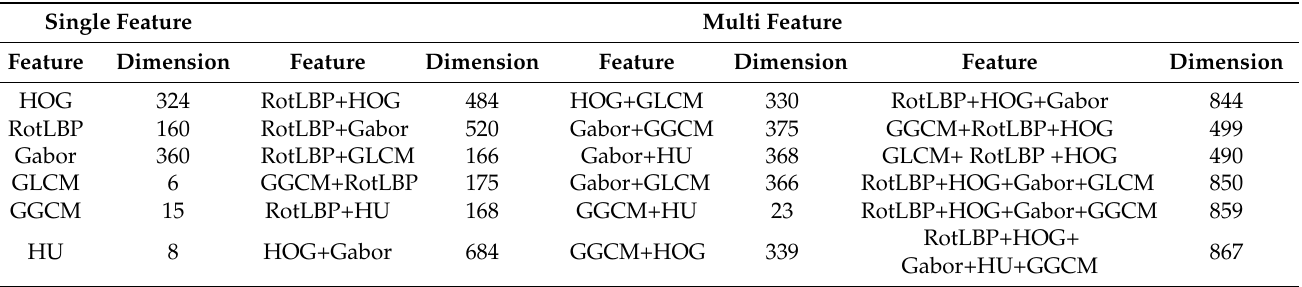
Table 4. Multi-feature fusion method and dimension before dimensionality